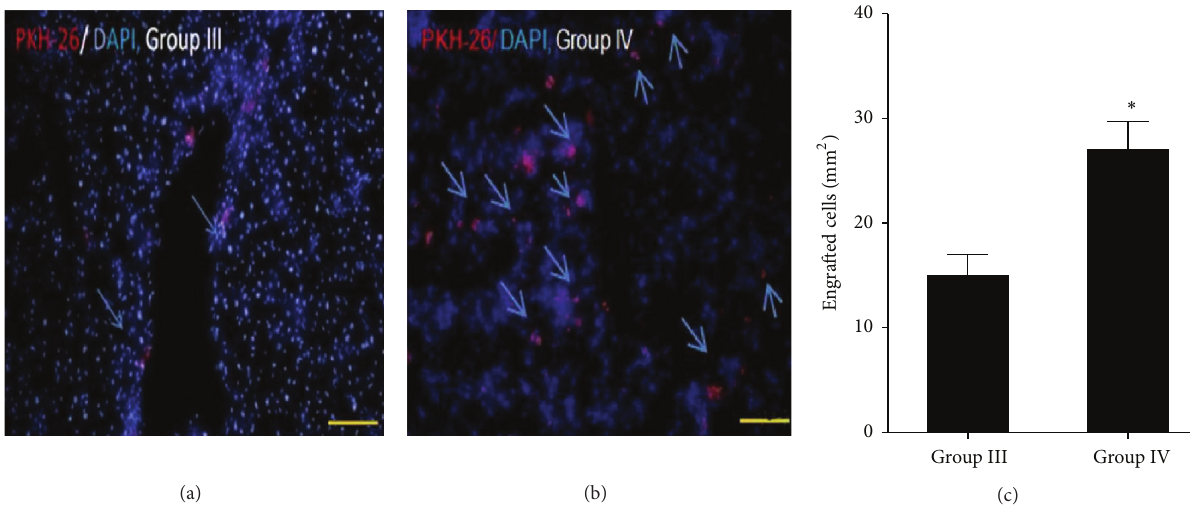
Figure 6: (a and b) Localization of untreated and cytokines pretreated MSCs in Group III and Group IV animals. (c) Quantification of engrafted cells in Groups III and IV. (100x, scale bar ∼ 100 𝜇 m). ∗ 𝑃 < 0.05 was considered to be significant.